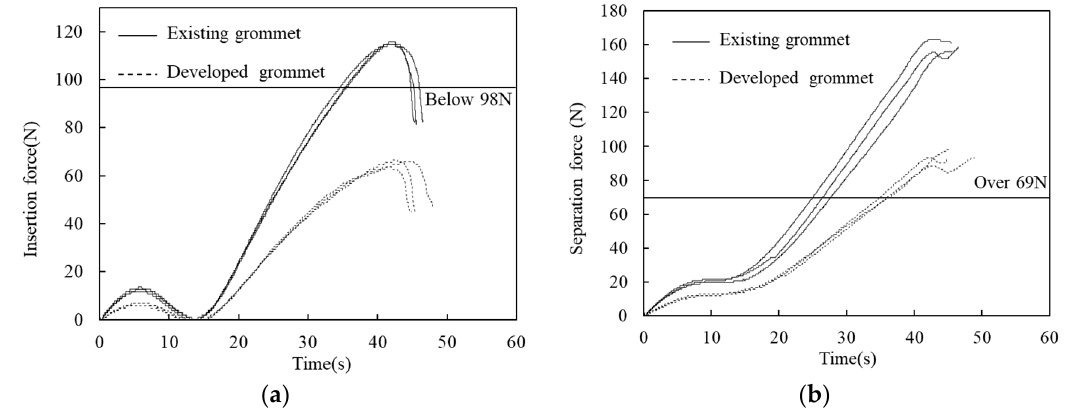
Figure 6. Results of the insertion and separation forces: ( a ) insertion force and ( b ) separation force.